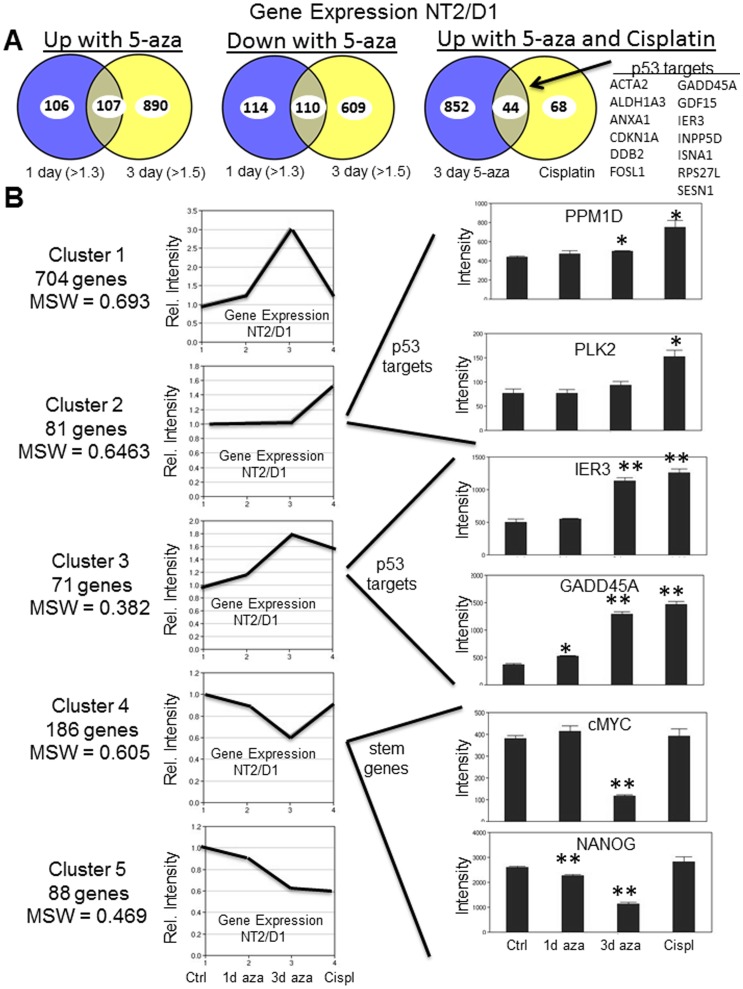
Low-dose 5-aza induces distinct genome-wide activation of p53 target genes and unique repression of pluripotency genes in NT2/D1 cells.
A, Venn diagrams of expression microarray data from Figure 2 indicating a large overlap in the genes upregulated (left) and down regulated (middle) in NT2/D1 cells with 1 day 5-aza treatment (fold change >1.3) compared to 3 day 5-aza treatment (fold change >1.5). A Venn diagram (right) of microarray data from Figure 2 showing a large degree of overlap in genes upregulated 1.5-fold or greater by both 3 day 5-aza and cisplatin treatments. Genes listed in each Venn diagram are altered with p<0.05. Of the overlap genes, 13 are known p53 target genes in NT2/D1 cells. B, Partitioning around mediods (PAM) analysis of 5-aza and cisplatin regulated genes in NT2/D1 cells. The 1130 genes changed 1.5-fold or greater with BH corrected p-value of <0.02 were subjected to PAM analysis as described in Methods. The number of genes in each of the five clusters and the mean silhouette width (MSW) value for each cluster is indicated. Expression intensity values for representative genes in Cluster 2, Cluster 3, and Cluster 4 is provided on the left. Error bars are S.E.M. * = p<0.05; ** = p<0.005 compared to untreated controls.